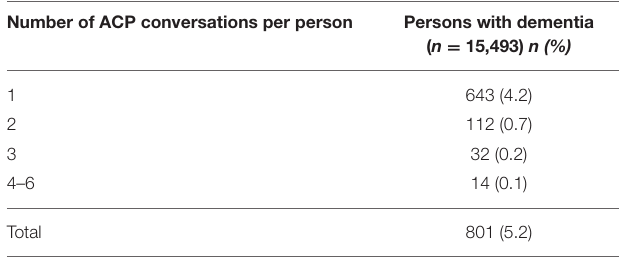
TABLE 2 | Number of ACP conversations conducted in the period